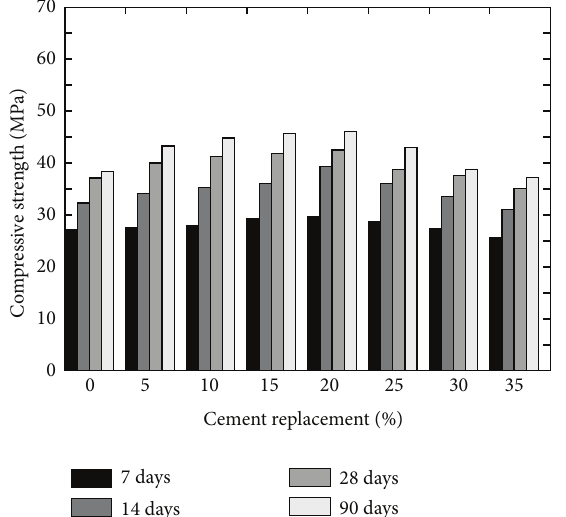
Figure 15: Effect of volume of cement replacement on the compres- sive strength of RHA concrete (w / b = 0.53 ) [5].